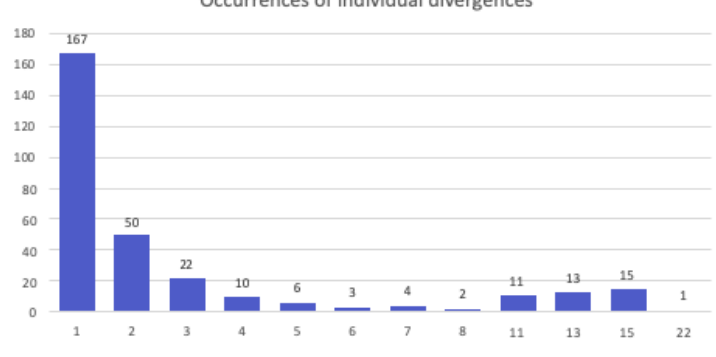
Figure 8. Occurrences of individual